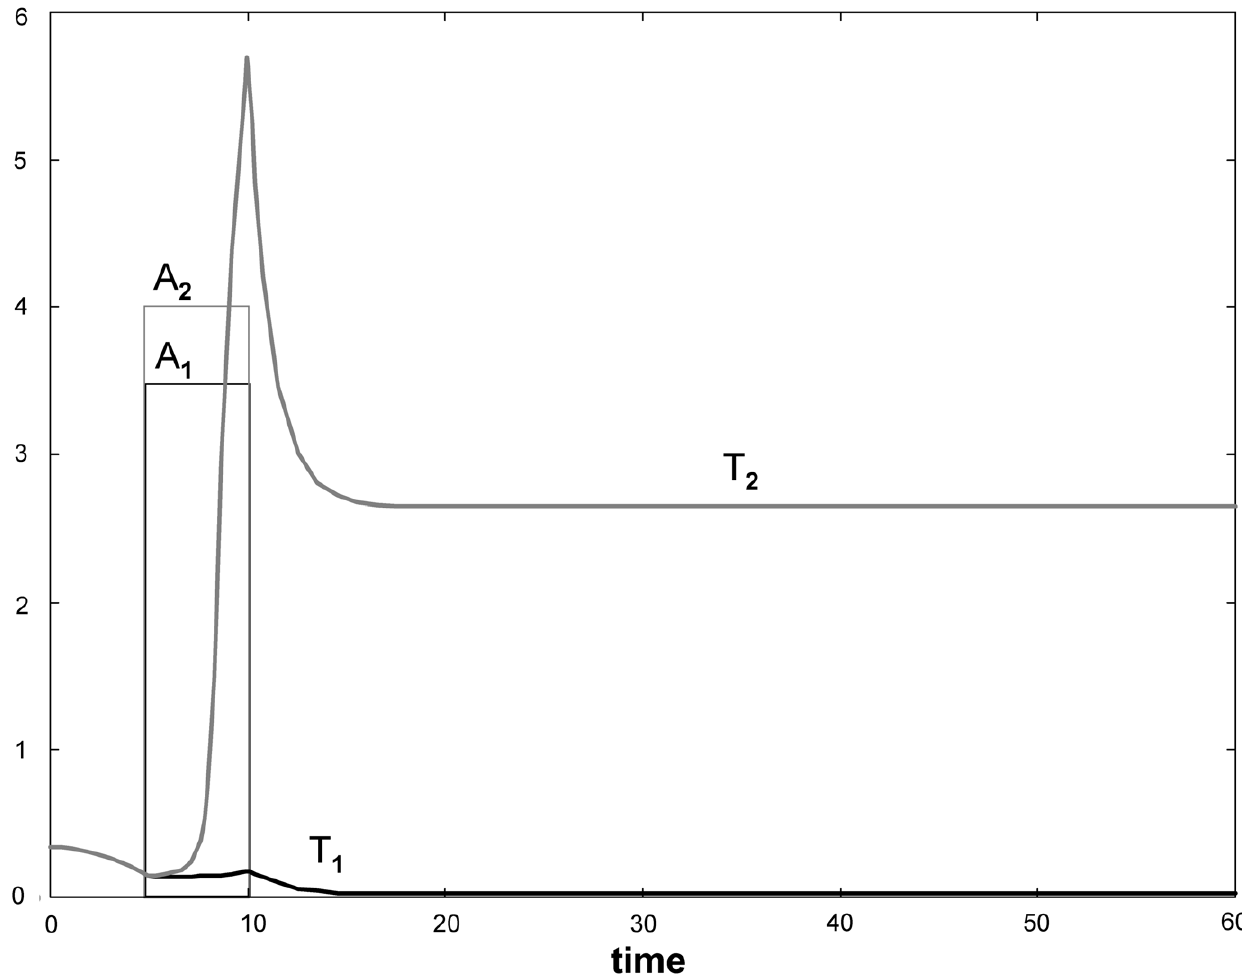
Figure 1. Bistable switching behavior of effector T cell (T) response. A simple model of the response of effector T cells to antigens and cytokines predicts a threshold of antigen level that triggers a Th1 immune response (see Eqns 1 and 2). T in Eqn 1 is interpreted as Th1 activity. A square pulse of antigen with amplitude A1=3.5 (applied from t=5 to t=10) fails to increase T , while increasing the amplitude to A2=4 leads to a rapid increase in Th1 activity at the level T2. Parameters: h T=1, b T=0.02, e T=1, c =3, g 1 = g 2 =1, initial T =0.34.